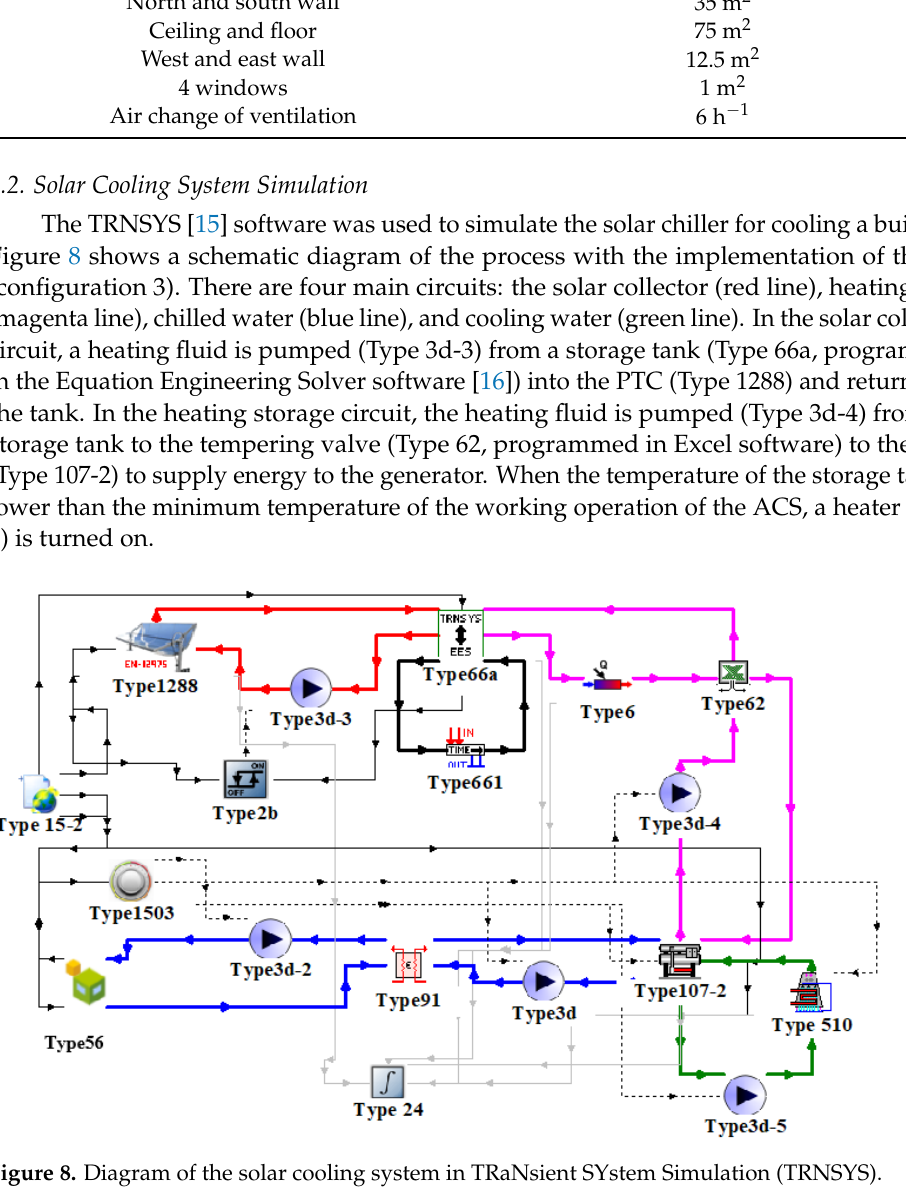
Table 3. Parabolic trough collector data. Parameter